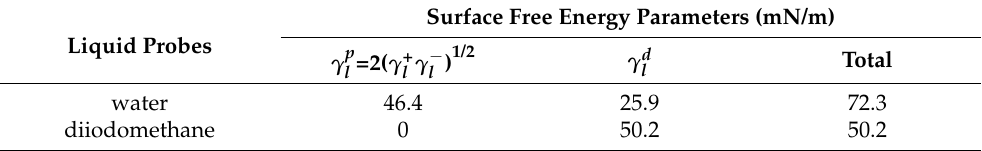
Table 1. Surface free energy components of the liquids used for the contact angle measurements at 23 ◦ C.